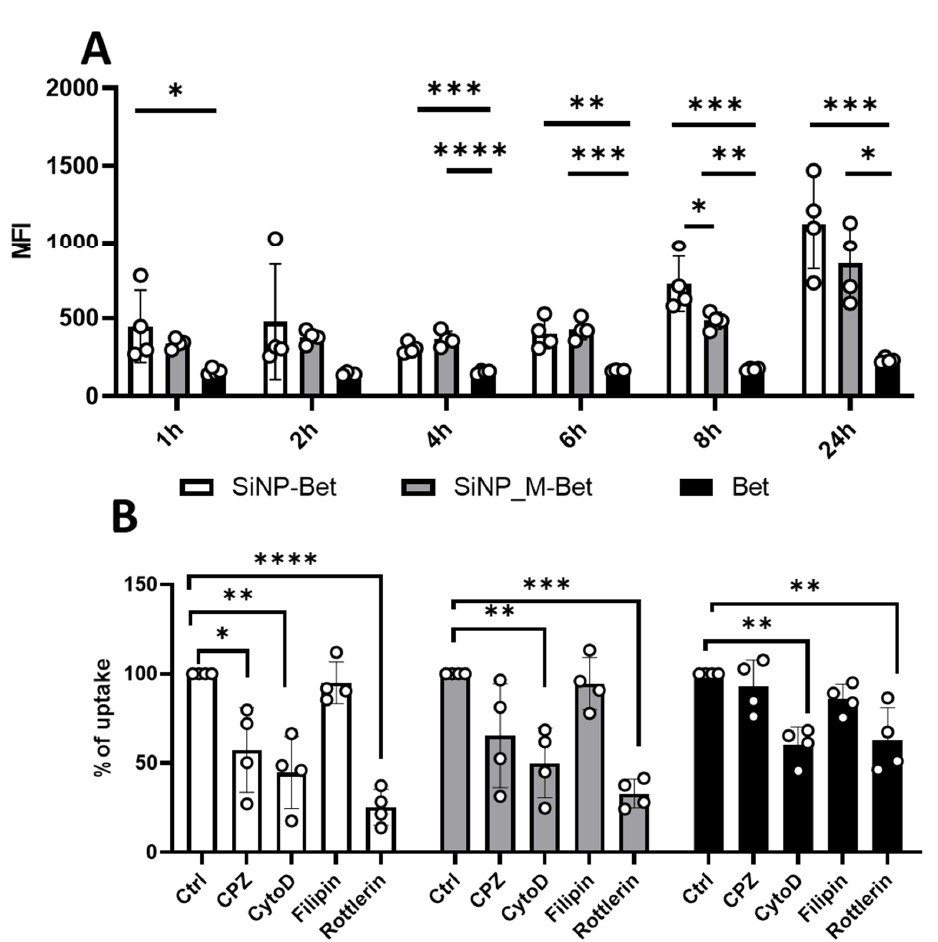
Figure 5. Impact on the uptake of allergen by moDCs. ( A ) Kinetics of uptake represented as mean fluorescence intensity (MFI) over the course of 24 h with SiNP-Bet, SiNP_M-Bet, and Bet. ( B ) Inhibition of uptake with the endocytosis inhibitors chlorpromazine hydrochloride (CPZ), cytochalasin D (CytoD), filipin, and rottlerin after stimulation with moDCs for 24 h ( n = 4 individual donors). The data are presented as mean ± SD (* p ≤ 0.05; ** p ≤ 0.01; *** p ≤ 0.001; **** p ≤ 0.0001).